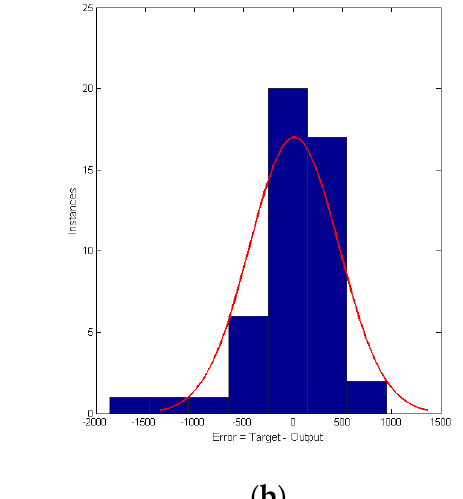
Figure 7. ( a ) Household No 71—Working days forecast error distribution; ( b ) household No 71— Weekend forecast error distribution.